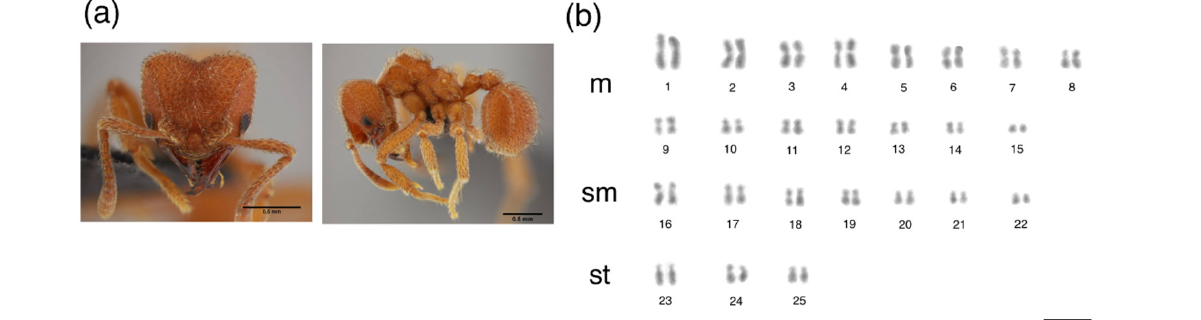
Figure 5. Mitotic chromosomes of Sericomyrmex parvulus stained with Giemsa. Species ( a ) images and ( b ) diploid karyotype of Sericomyrmex parvulus with 2 n = 50 chromosomes. m = metacentric; sm = submetacentric; st = subtelocentric. Scale bar = 5 µ m. Ant image from AntWeb (www.antweb.org, accessed on 13 June 2021): Sericomyrmex parvulus (UFV-LABECOL-000372, photo by: J. Chaul). Table 5. Fungus-farming ants cytogenetically studied to date and the new reports from the present study. The heterochro- matic pattern evidenced by C-band technique, karyotype structure (formula), and genome size is highlighted.